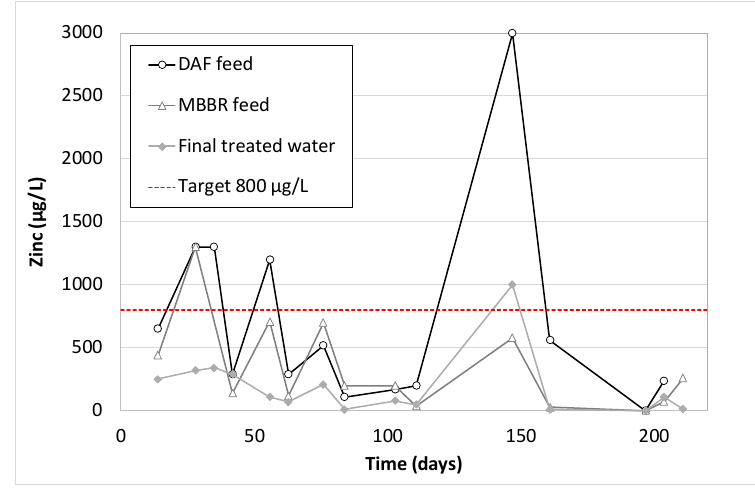
Figure 15. Barium concentration along the pilot unit versus time of operation.